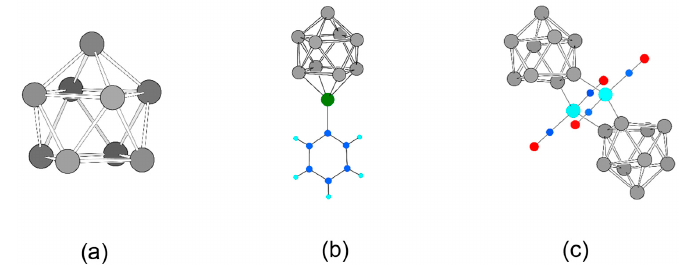
Figure 1. The building block nido -[Si 9 ] 4– and its experimentally accessible complexes from solution. ( a ) nido -[Si 9 ] 4– optimized on a DFT-PBE0/def2-TZVPP/PCM level of theory; ( b ) closo-[Si 9 Zn(C 6 H 5 )] 3 − [39]; ( c ) [{Ni(CO) 2 } 2 ( μ -Si 9 ] 2 ] 8– [40,44]. Si, C, H, Zn, Ni, and O are shown as grey, blue, light blue, green, turquoise, and red spheres.